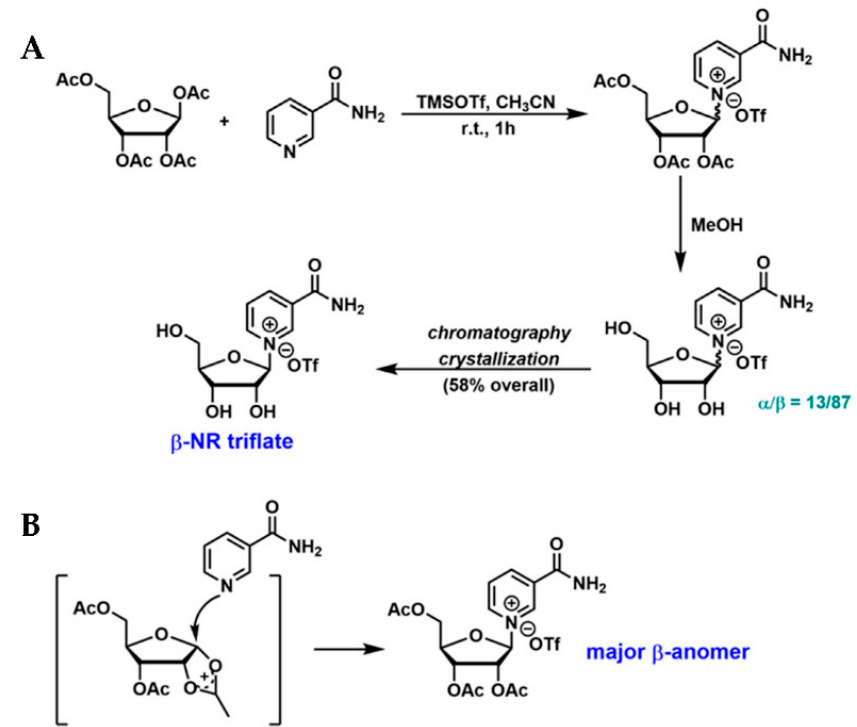
Figure 2. NR synthesis: glycosylation of NAM and acetylated- D -ribofuranose. ( A ) Synthetic scheme